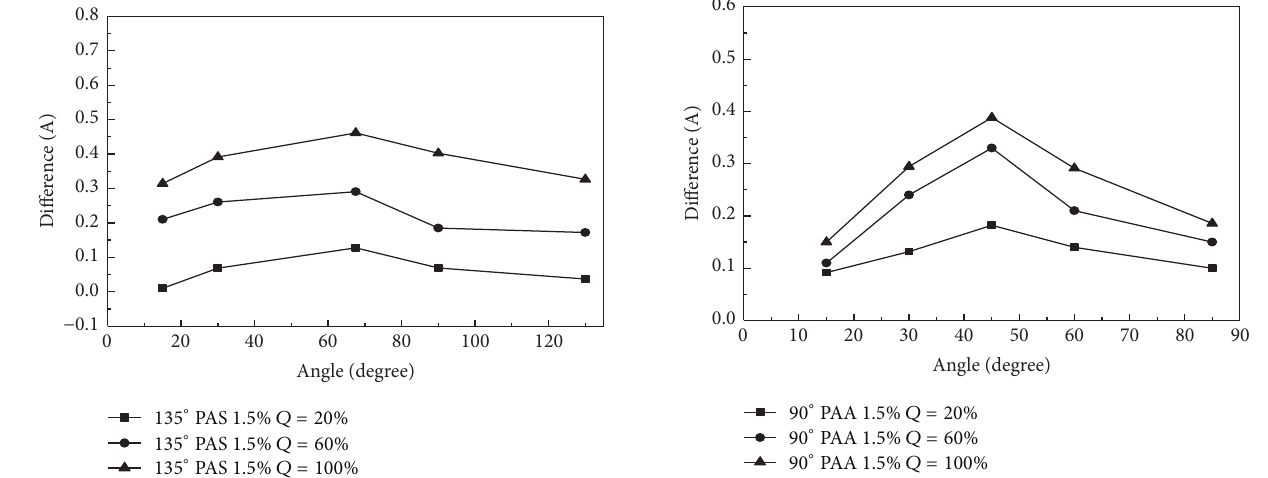
Figure 26: The PAA 1.5% angle of curved tube: difference diagram of various flows in 90 ∘ curved